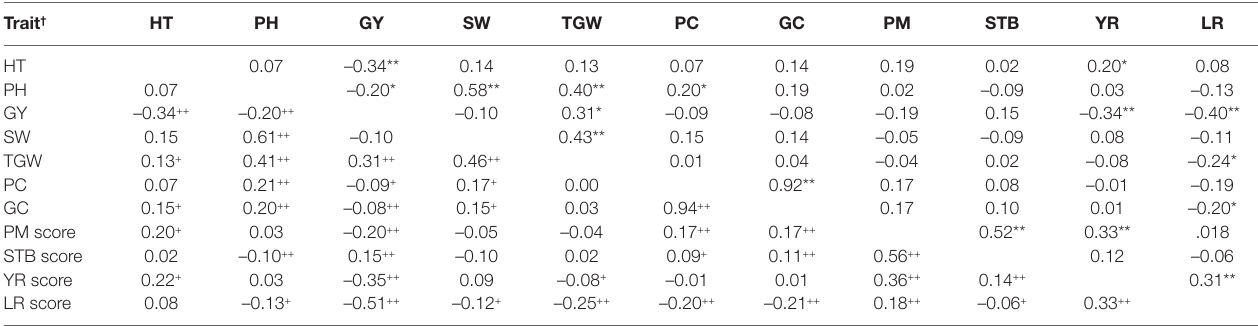
TABLe 5 | Phenotypic (above diagonal) and genotypic (below diagonal) coefficients of correlation ( r ) between the 11 agronomic and disease-resistance traits for the 800 genotypes evaluated in 2013–2015. Trait † HT PH GY SW TGW HT